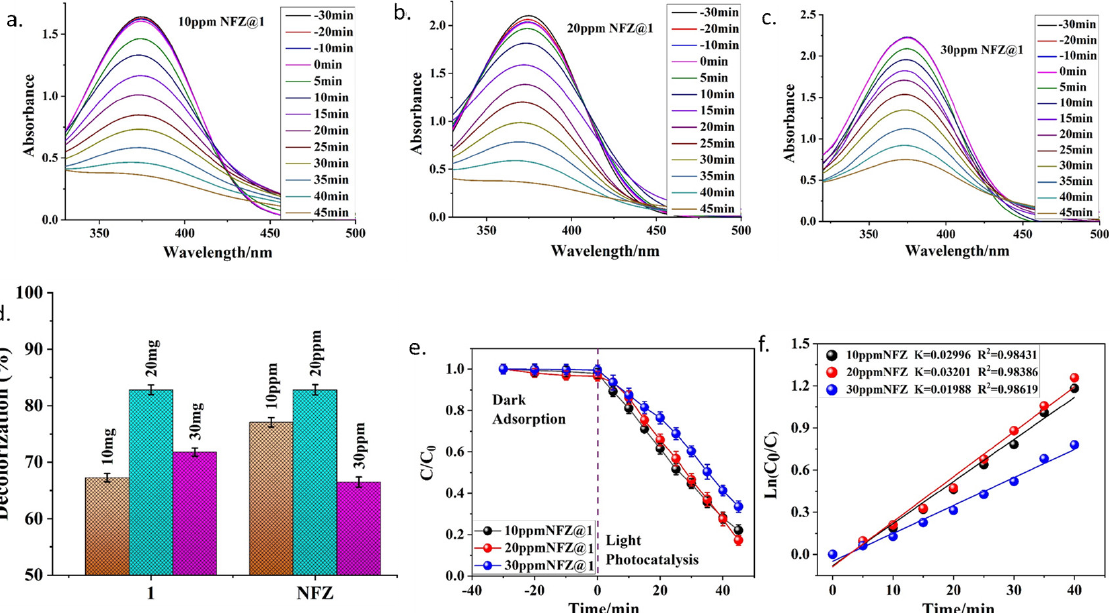
Figure 5. ( a – c ) UV spectra of different concentrations of NFZ dye at 10, 20, and 30 ppm with 1 . ( d ) The comparative degradation efficiency at different NFZ concentrations. ( e , f ) Kinetic plots for the photocatalytic degradation of NFZ using 1 under various NFZ